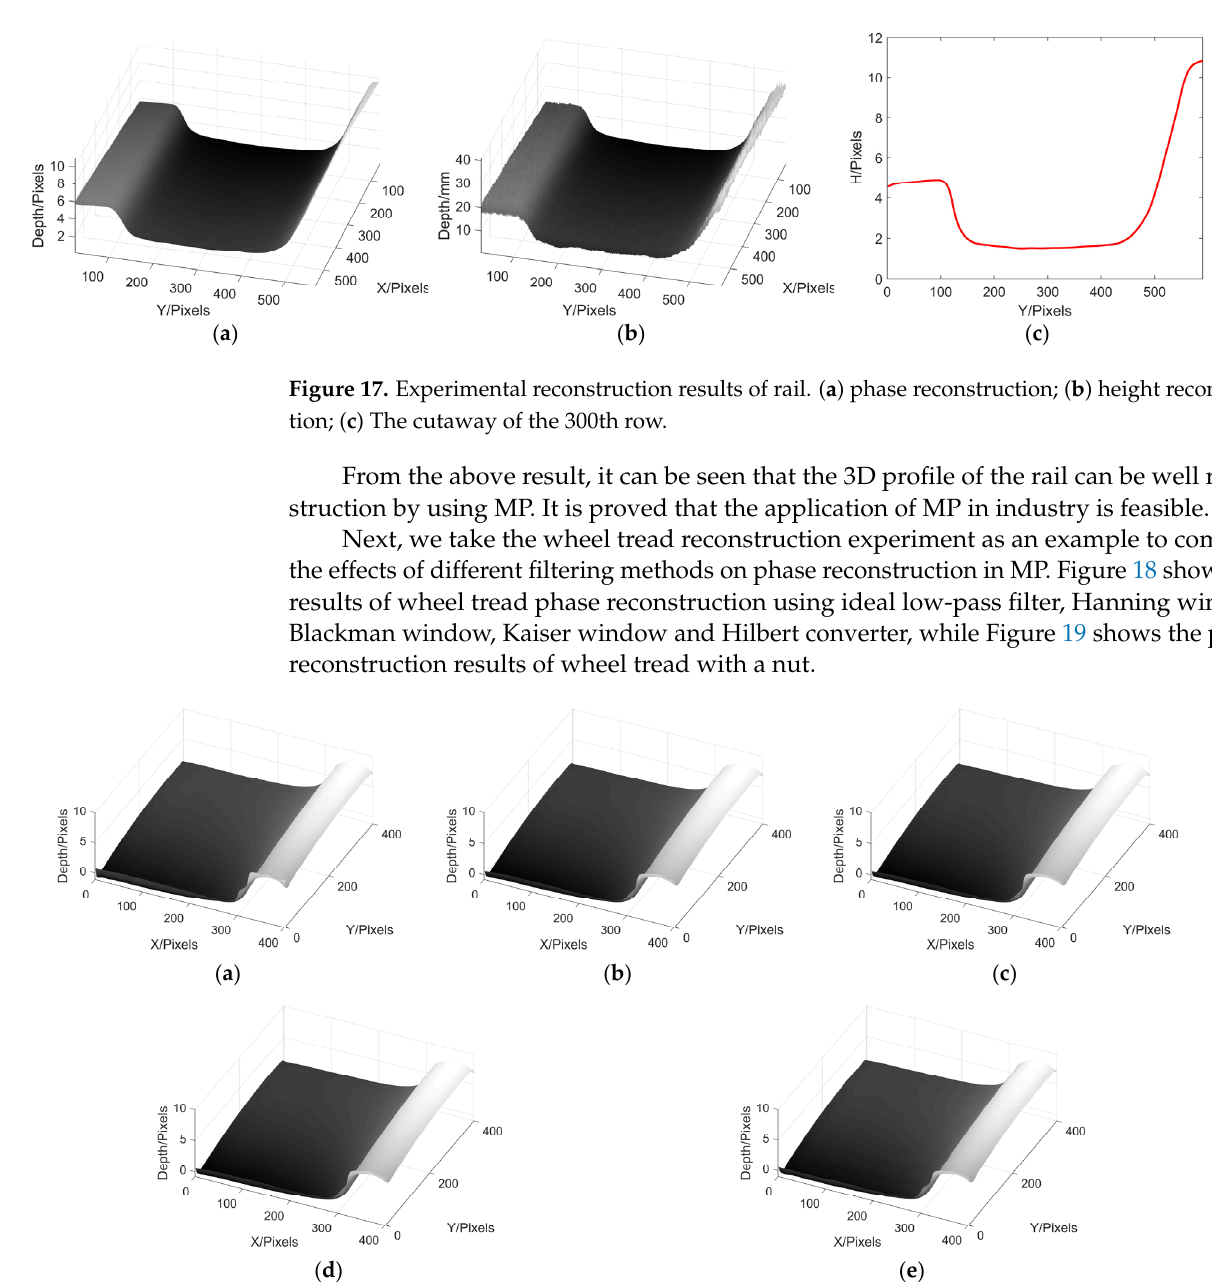
Figure 16. Rail shape and deformed fringe pattern.